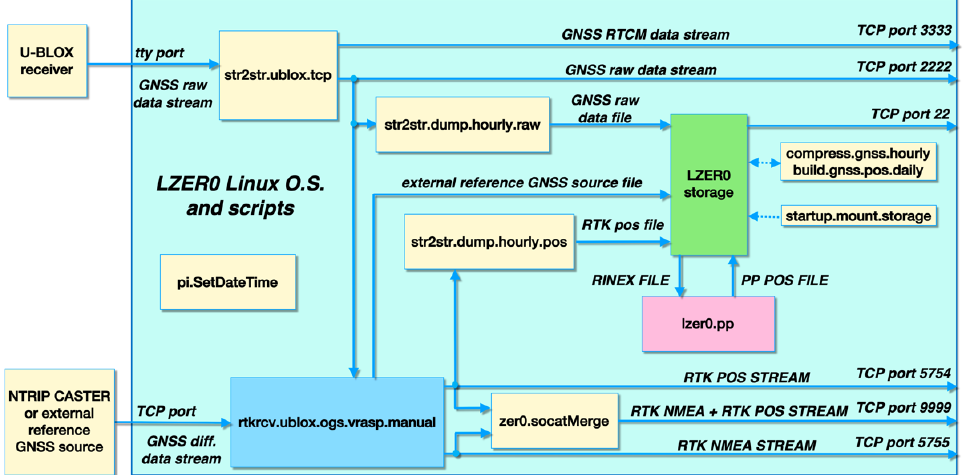
Figure 1. Data flow in the LZER0 instrument (cyan block) and an indication of working scripts (yellow boxes, see also Table 2 and Supplementary Material Section SA). The code captures the raw data coming from the GNSS chipset (in this case, a u-blox model), combines it with GNSS corrections coming from an external source (Networked Transport of RTCM via Internet Protocol–NTRIP–Caster), and produces accurate real-time coordinates. The results are finally made available via various TCP ports. Table 2. Scripts that control the internal software system of the LZER0 device. For more details, see Supplementary Material Section SA.